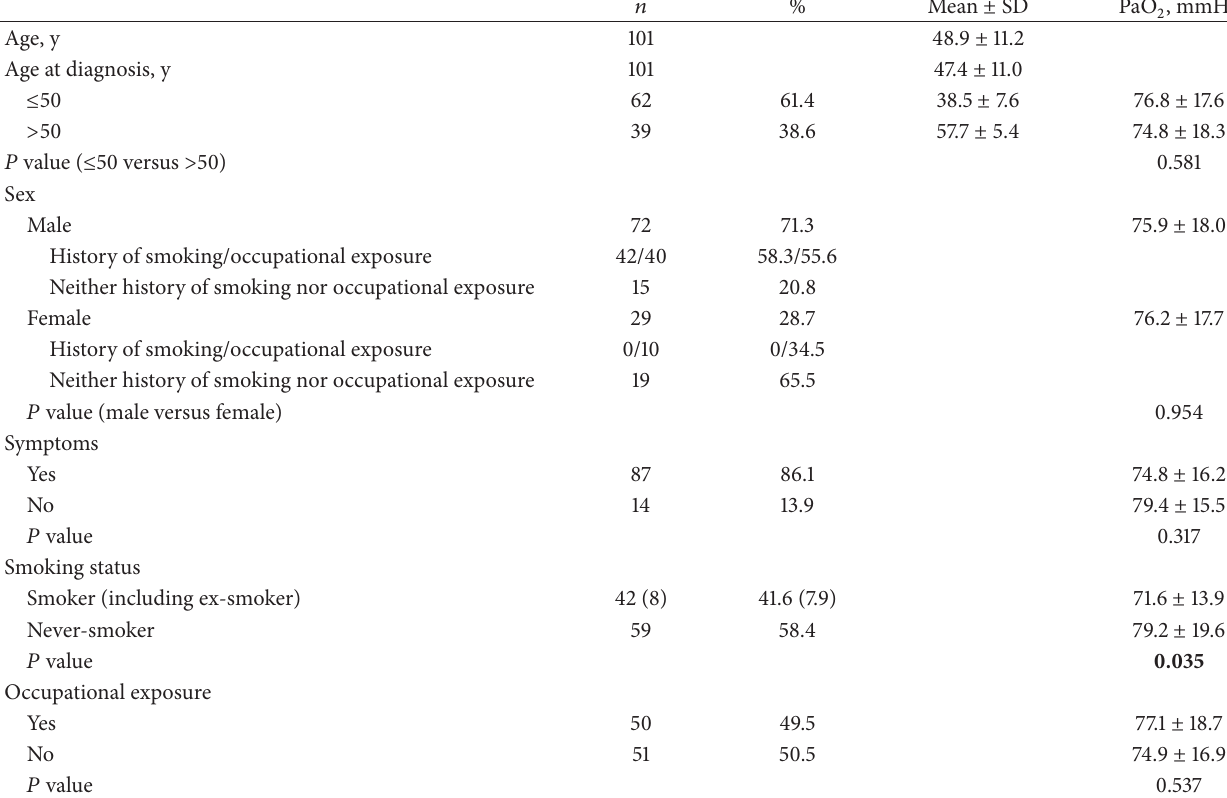
Table 1: Demographic and clinical characteristics of the patients with PAP.